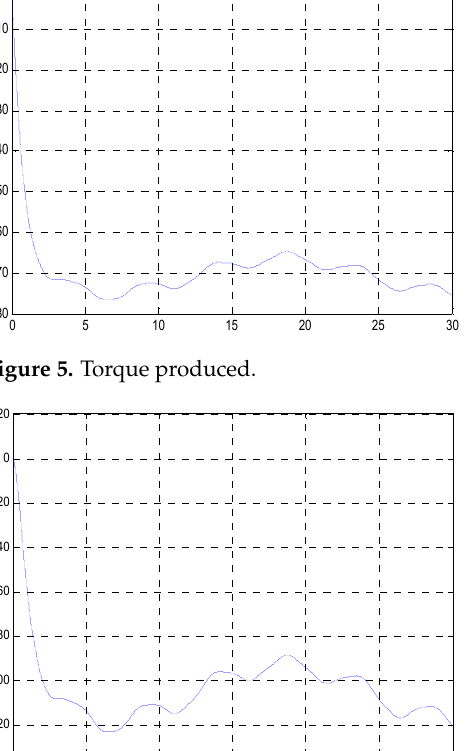
Figure 6. Electric power (N.m).